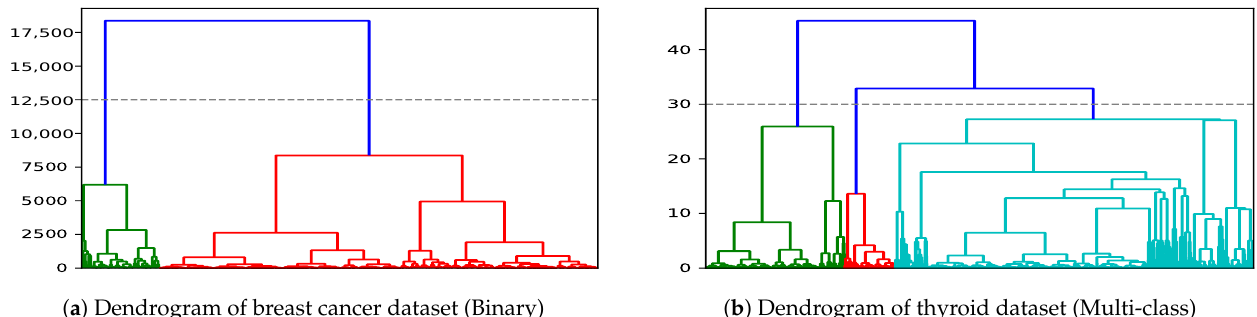
Figure 3. Dendrograms of binary and multi-class